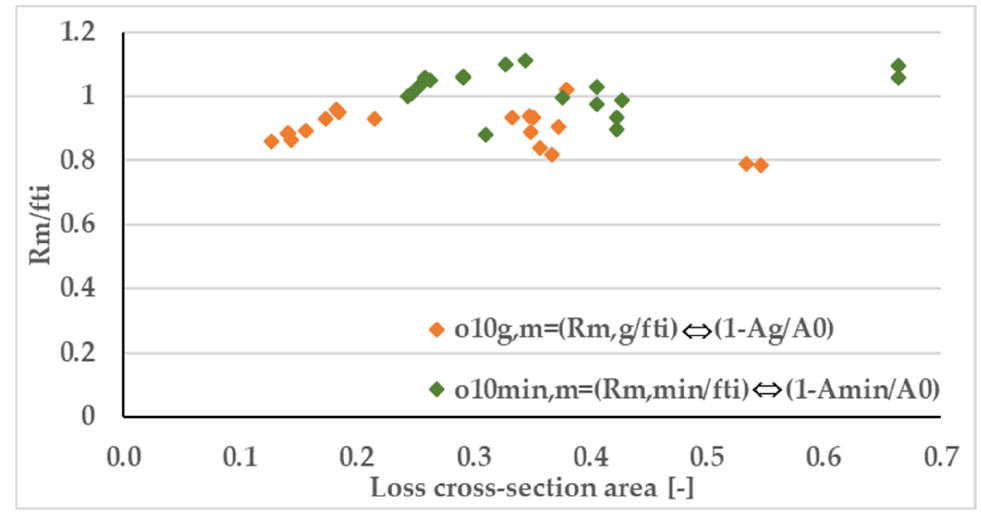
Figure 17. Dependence of the tensile strength ratio of the corroded to non-corroded samples (R m,g /f t ) and (R m,min /f t ) on the relevant loss of cross-sectional area of reinforcement ϕ 10 ((1 − A g /A 0 ) or (1 − A min /A 0 )).